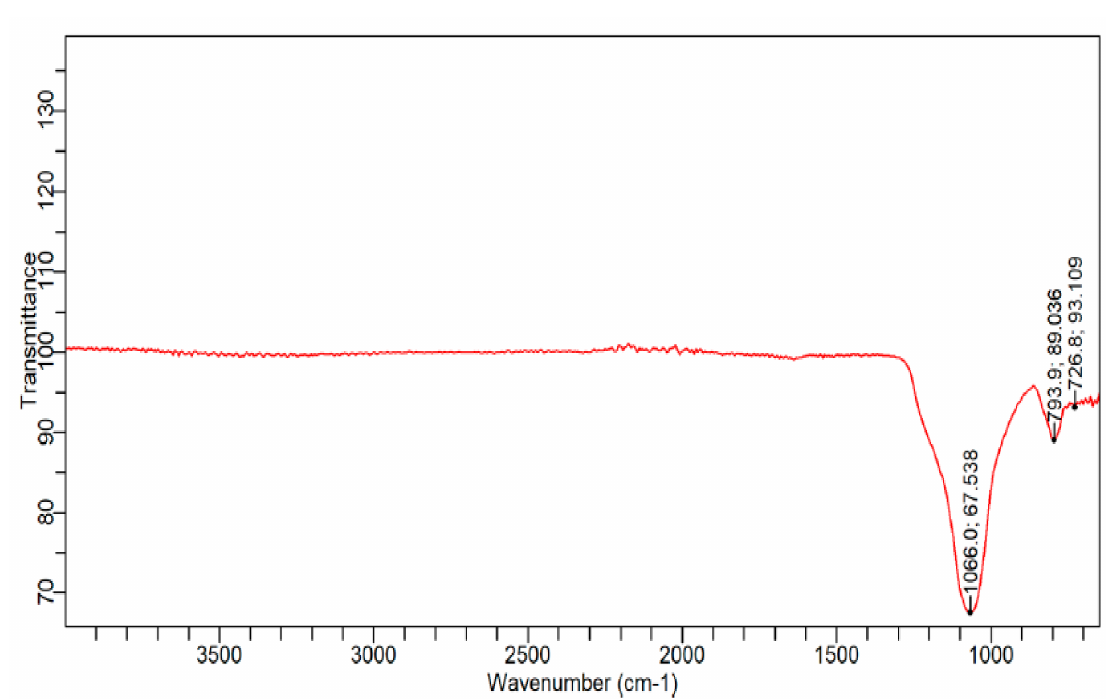
Figure 7. The FTIR/ATR spectra of